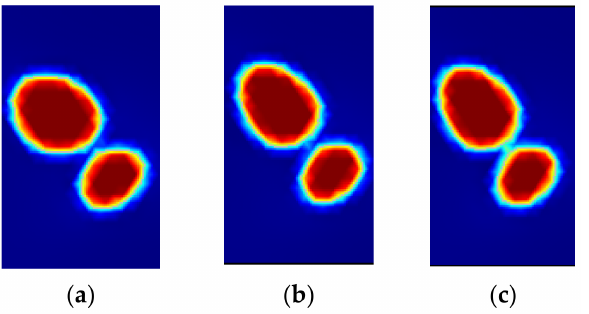
Figure 6. Comparison of physical fields. ( a ) Flow field, ( b ) electric field, ( c ) coupling field. When voltage was 10 kV and the flow speed was 0.05 m/s, the process of oil droplets’ coalescence with time under the coupling field is shown in Figure 7.